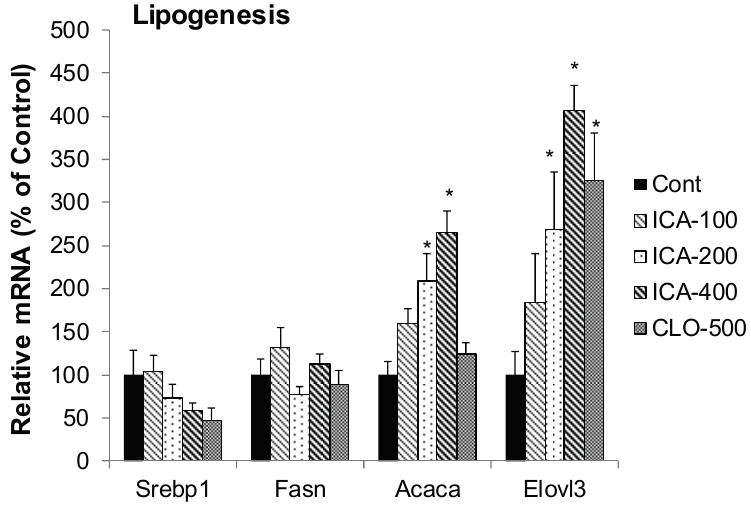
Figure 5. Effects of Icariin (ICA) on Expression of lipogenesis enzymes. Data are expressed as mean ± SEM (n = 5). * Significantly different from CMC-treated mice ( p <